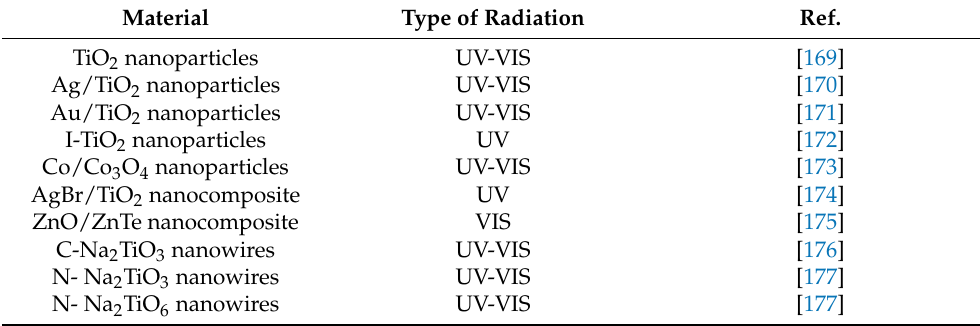
Table 2. Examples of photocatalysts used in the photoconversion of carbon(IV) oxide reaction to hydrocarbons under UV radiation in the ultraviolet range and VIS radiation in the visible